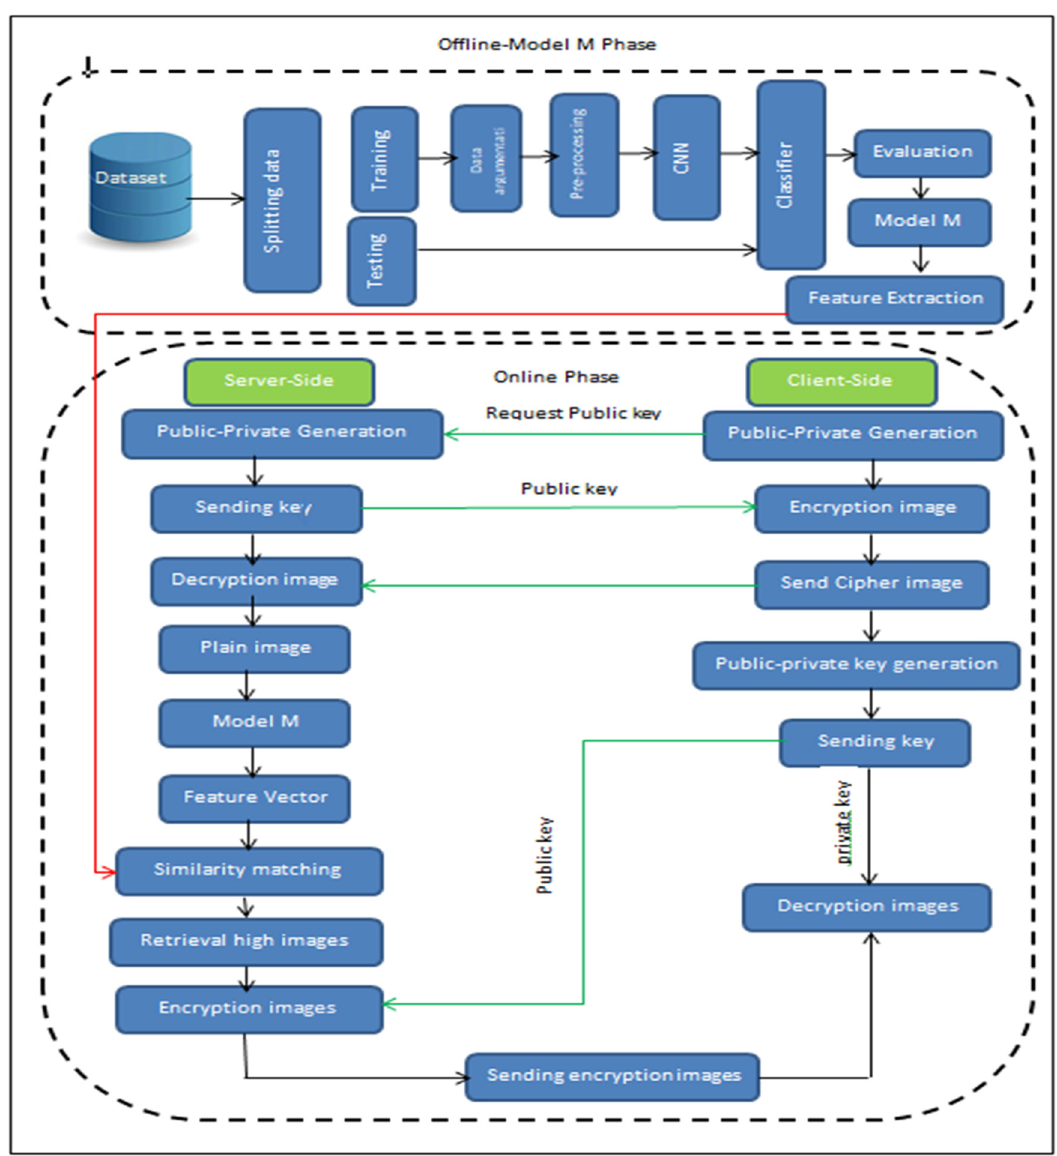
Figure 2: O ffl ine and Online Phases RCNN_CKKS